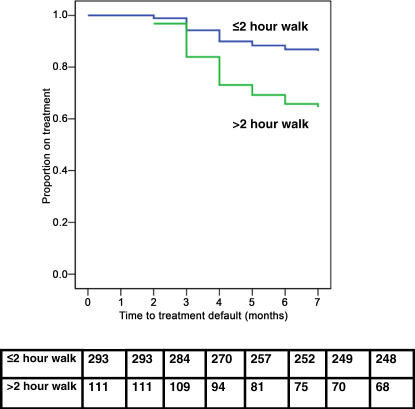
Survival Curve of Time on Treatment by Walking Distance from Treatment Centre, Adjusted by Cox Regression Analysis